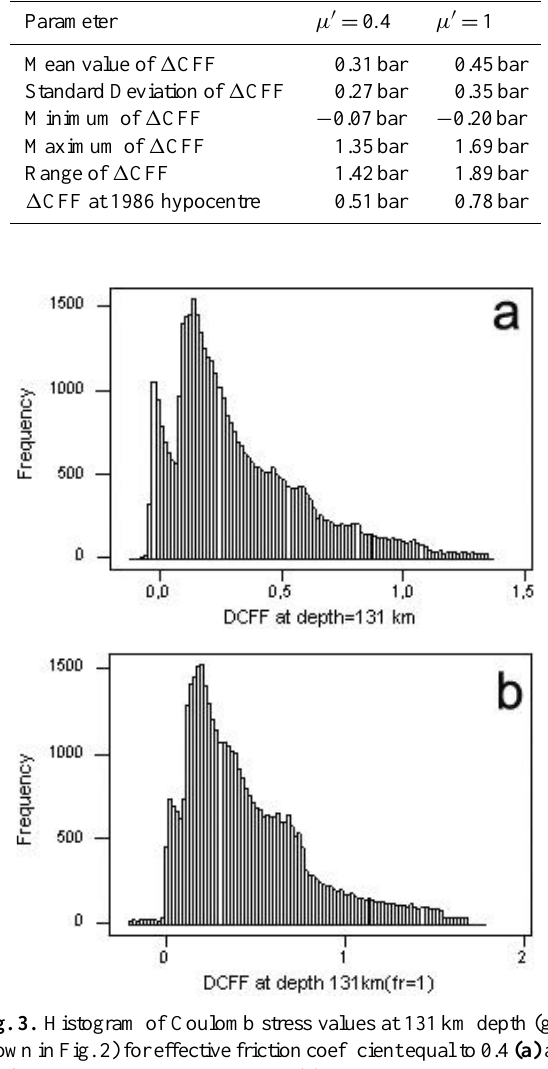
Fig. 3. Histogram of Coulomb stress values at 131km depth (grid shown in Fig. 2) for effective friction coefficient equal to 0.4 (a) and 1 (b) , respectively. It is seen that in (b) histogram values are shifted to the right (i.e. greater) along the x-axis (stress values).